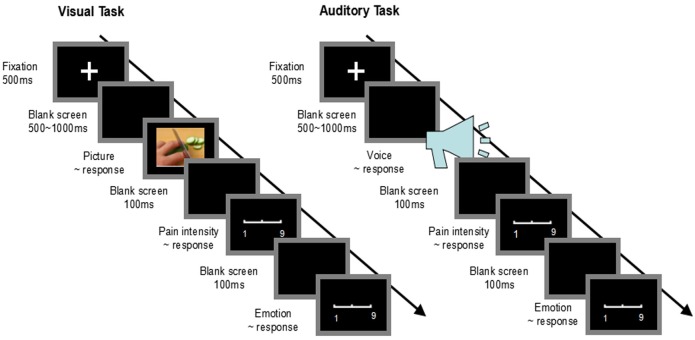
Flowchart describing experimental designs.Left column: Procedure of Visual Task. Right column: Procedure of Auditory Task.